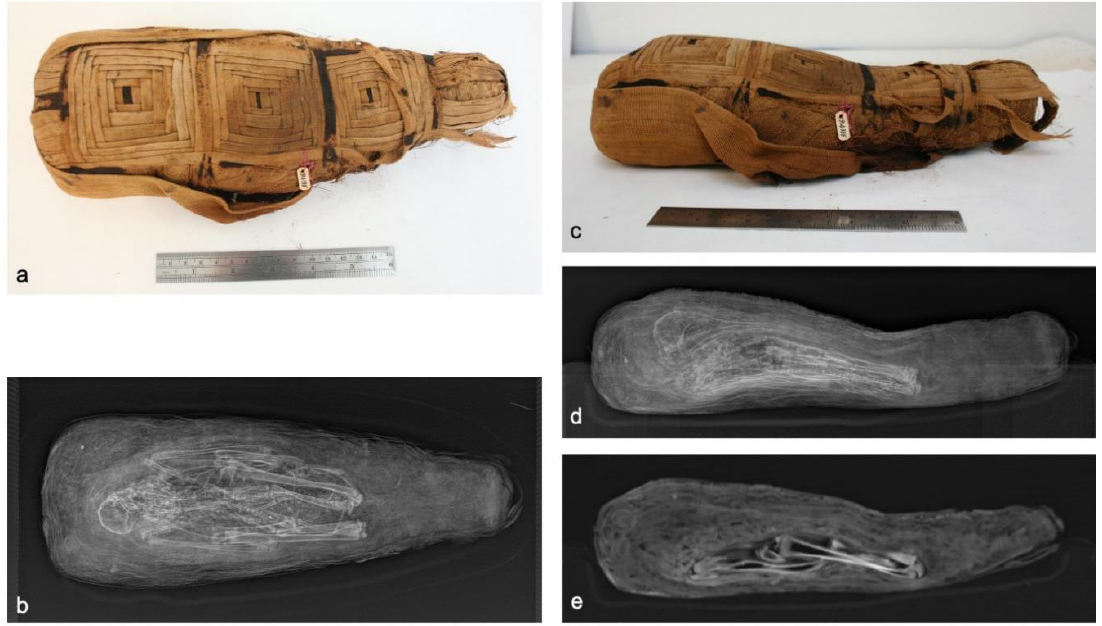
Figure 7. Figure demonstrating the bundle elongation of mummy MFA acc. no. 6200.4 and the juvenile bird within. Images ( a ) anterior posterior photograph, ( b ) anterior posterior radiograph, ( c ) lateral photograph ( d ) lateral radiograph, and ( e ) sagittal CT reformat showing an unfused epiphysis on the distal tibiotarsus. [Photographs and radiographs created by author for the Ancient Egyptian Animal Bio Bank.].